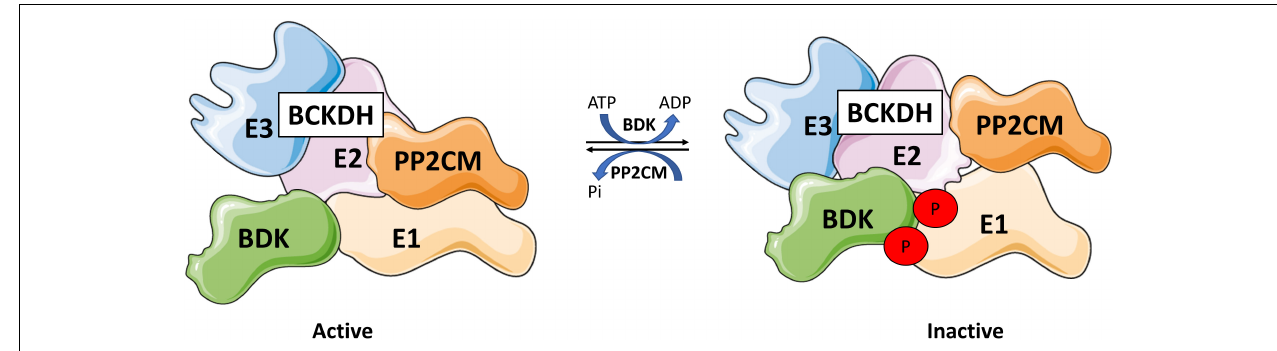
FIGURE 6 | Branched-chain ketoacid dehydrogenase regulation. BCKDH is regulated by a kinase, branched-chain ketoacid dehydrogenase kinase (BDK), and a phosphatase, protein phosphatase 2Cm (PP2Cm) that interact with E1 subunit. BDK phosphorylates BCKDH at Ser293 and 303 inhibiting BCKDH, while PP2Cm dephosphorylates BCDKH, reactivating the complex. Drawn using information from Damuni et al. (1984) and Popov et al. (1991).